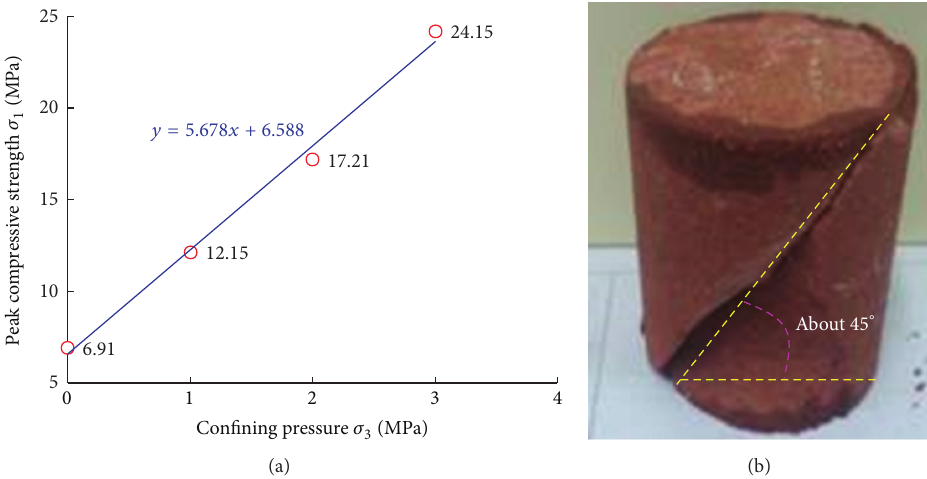
Figure 7: The results of the triaxial compressive test: (a) relationship between the confining stress and the failure stress of rock sample and (b) the failure pattern of the natural highly weathered Zigong argillaceous siltstone.